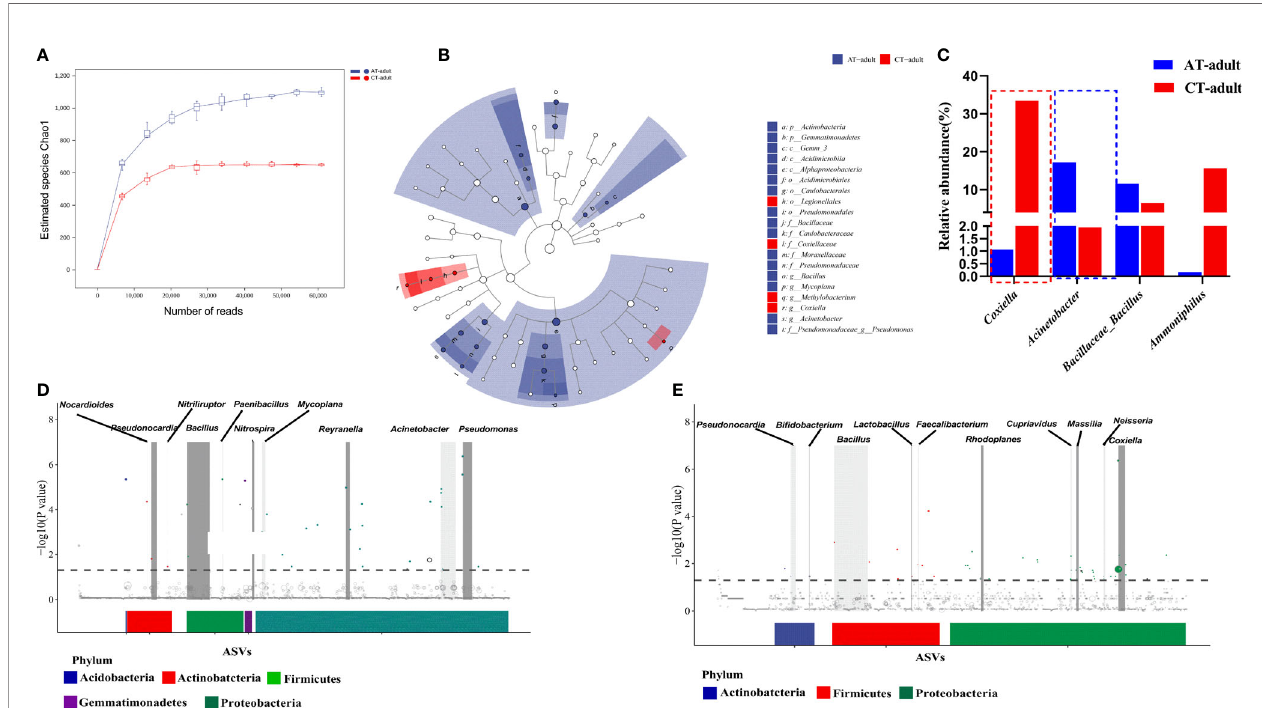
FIGURE 2 | Antibiotics used on mice resulted in tick microbiota dysbiosis. (A) Rarefaction curve of the estimated number of genera using the Chao1 method. (B) Cladogram for taxonomic representation of signi fi cant differences between two groups. (C) Percentages of the most abundant genera in AT adults and CT adults. (D, E) Manhattan plots showing the abundance enrichment in the AT adults (D) and CT adults (E) . The dashed line represents the P = 0.05 threshold of signi fi cance.The color represents the different taxonomic af fi liation of the ASVs (phylum level), and the dot size corresponds to their relative abundance in the respective samples. Gray boxes denote the different taxonomic groups (genus level).